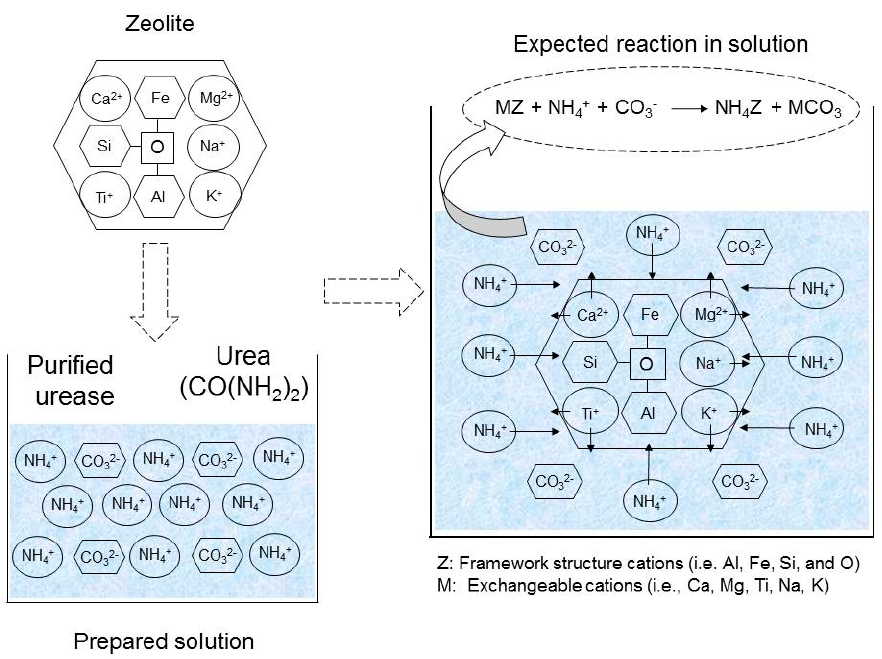
Figure 2. Expected mechanism of ion exchange process and the reaction in the presence of zeolite.